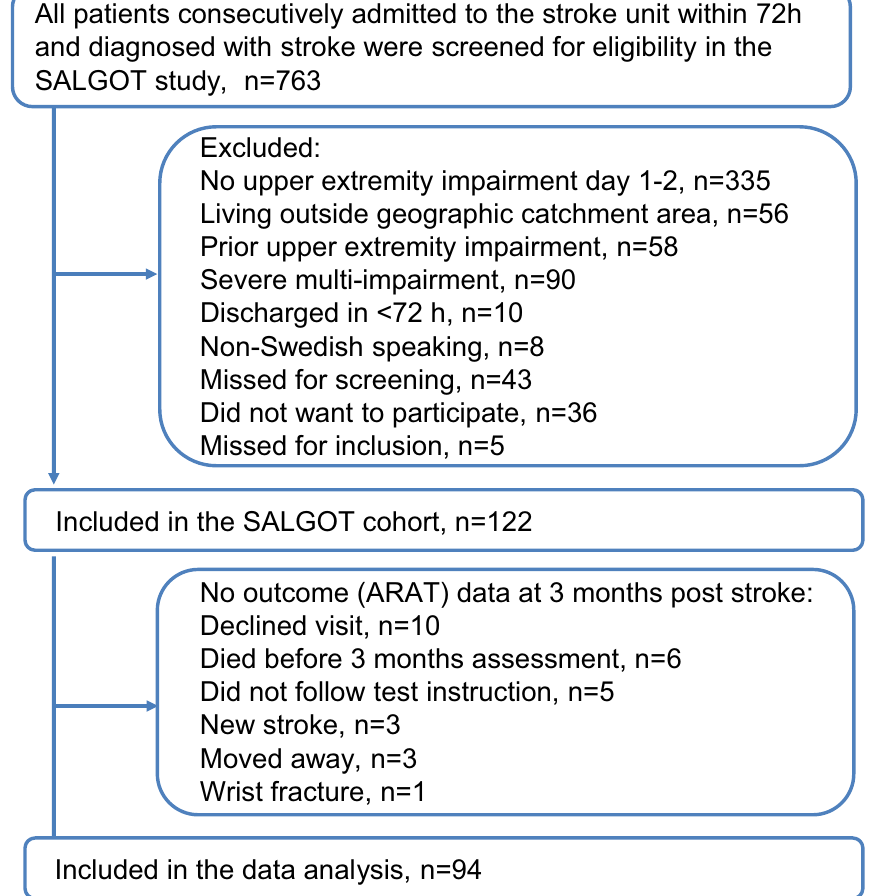
Figure 1. Flowchart over the inclusion process for the study group. SALGOT Stroke Arm Longitudinal Study at Gothenburg